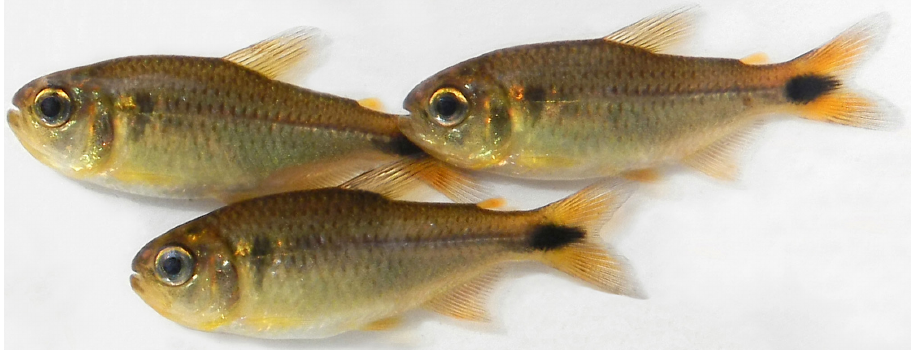
FIGURE 5 | Paratypes of Moenkhausia cambacica , MZUSP 125793, freshly collected, showing other aspects of its live coloration, Brazil, Rondônia State, Municipality of Vilhena, rio Madeira basin, upper rio Machado